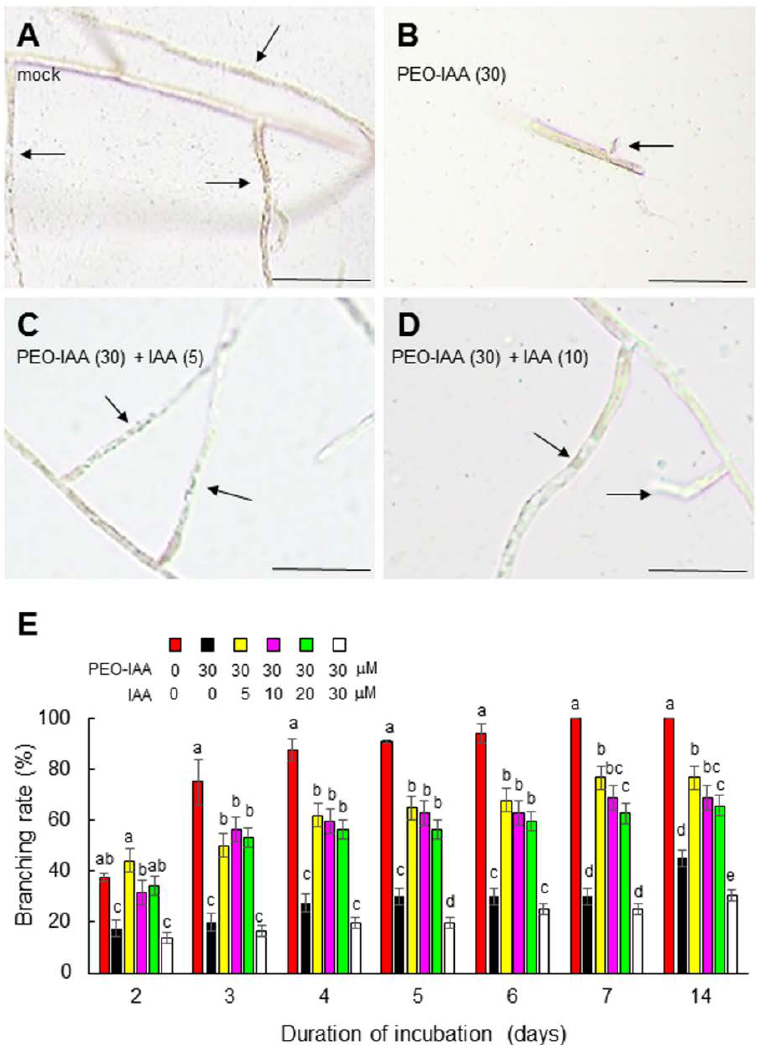
Figure 3. Reversal of the inhibitory effects of PEO-IAA following exogenous treatment with IAA. ( A ) Growth of side branches produced from a single-celled conchocelis following 2 weeks of culture. Arrows indicate side branches. Scale bars: 50 μm. ( B – D ) Photographs of typical single-celled